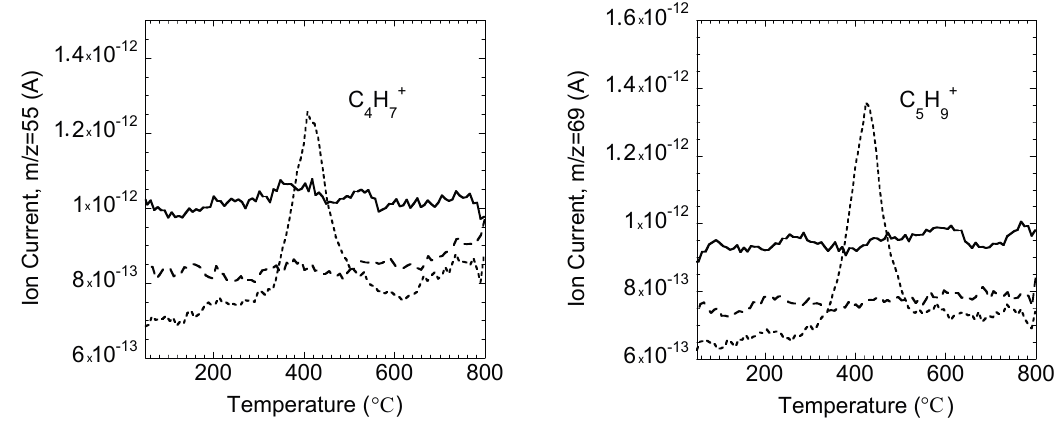
Figure 8. TGA-MS coupled analysis of original Kraft lignin (continuous line), control Kraft lignin extracted from the [C 4 C 1 mim][OTf]/[C 4 C 1 mim][PF 6 ] binary system without enzyme (large dotted line) and lignin oleate extracted from the [C 4 C 1 im][OTf]/[C 4 C 1 im][PF 6 ] binary system after transesterification catalyzed by the immobilized lipase B from Candida antarctica (small dotted line) as function of